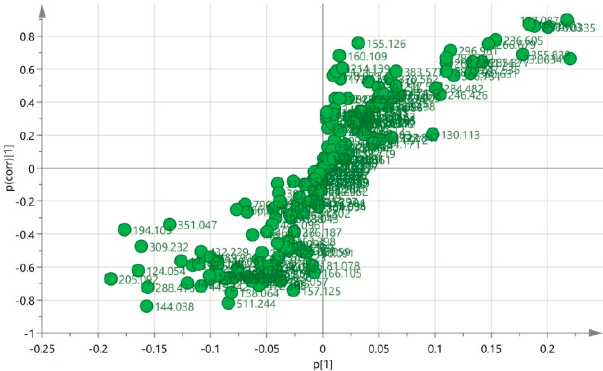
Figure 6. Score plot of principal component analysis (PCA) obtained based on the urine samples from the 0-unit group (green circle) and 50-unit group (blue circle).